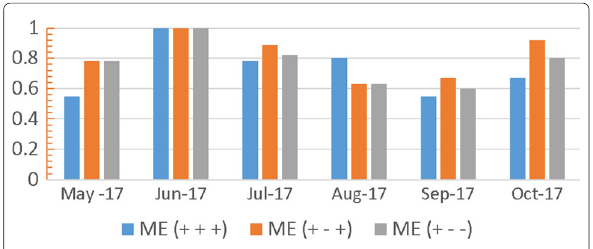
Fig. 5 F -Measure values for (+ + +) , (+ - +) , and (+ - -) cases for each tested month for the EM attack type